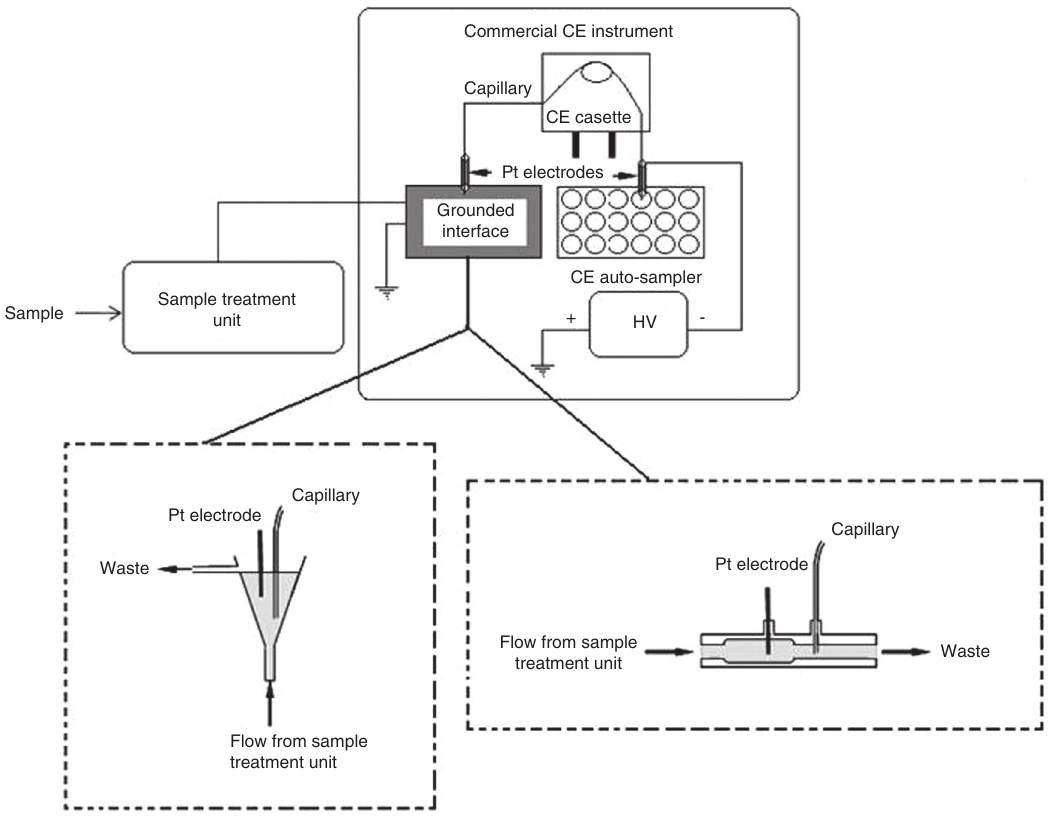
Figure 2 Schematic description of an on-line coupling sample treatment unit to commercial CE equipment using a vertical and horizontal design of split-flow